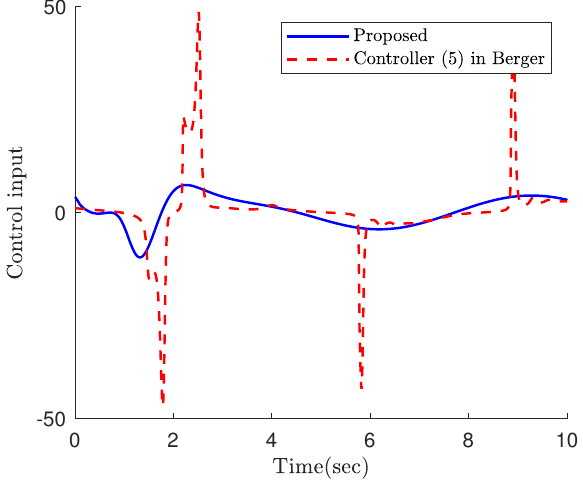
Figure 14. The control input in Part 3.